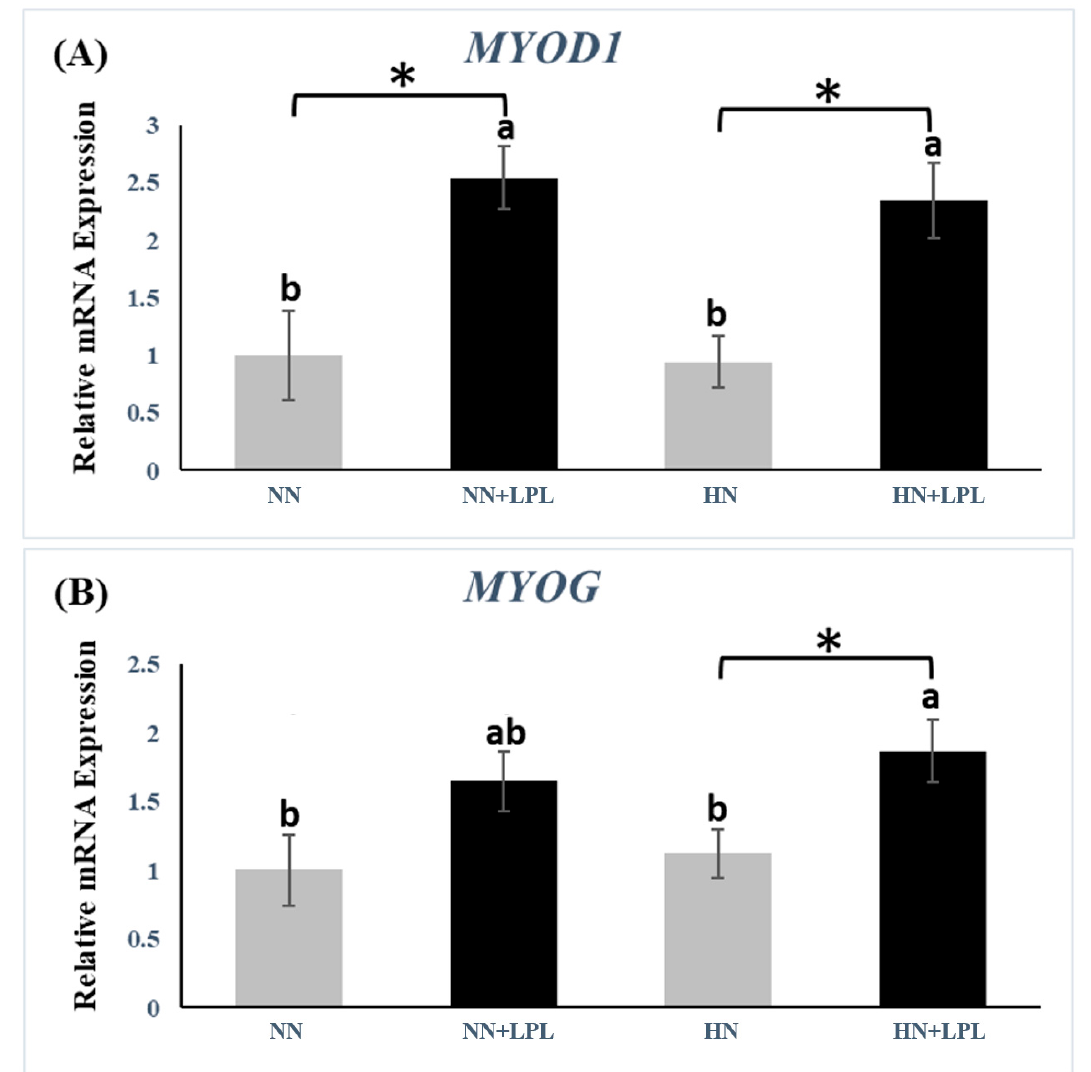
Figure 2. Quantitative genes expression of growth-related genes in muscle following LPL supple- mentation. (A) The gene expression of MYOD1. (B) The gene expression of MYOG. Significant dif- ferences between basal diet and diet with LPL supplementation groups are indicated by * p < 0.05 and ** p < 0.01. a,b Bars with no common letter differ significantly ( p < 0.05). Error bars indicate the standard error of the mean. MYOD1, myogenic differentiation 1; MYOG, myogenin. Abbreviation: NN, Normal nutrition diet; NN + LPL, NN + 500 g/t of LPL; HN, NN + 0.5% CP and 50 Kcal/kg; HN + LPL, HN + 500 g/t LPL.